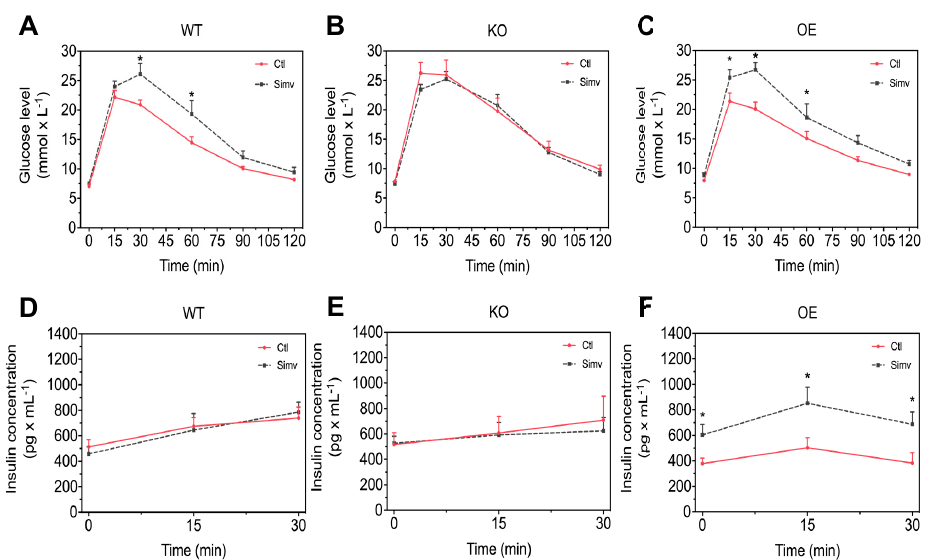
Figure 2. Intraperitoneal glucose tolerance test. Mice were studied after starvation for 6 h. Blood glucose concentrations were measured over 120 min and insulin plasma concentrations over 30 min after intraperitoneal injection of 2 g/kg glucose. Glucose concentrations are shown for WT mice ( A ), KO mice ( B ), and for OE mice ( C ) and plasma insulin concentrations for WT mice ( D ), KO mice ( E ) and for OE mice ( F ). After two-way ANOVA analysis, treatment factor was significant in ( A , C , F ). Data are presented as mean ± SEM of 10 animals per group. * p < 0.05 between simvastatin-treated and respective control mice. Ctl, control; KO, PGC-1 α knock-out mice; OE, PGC-1 α overexpressing mice; Simv, simvastatin; WT, wild-type.